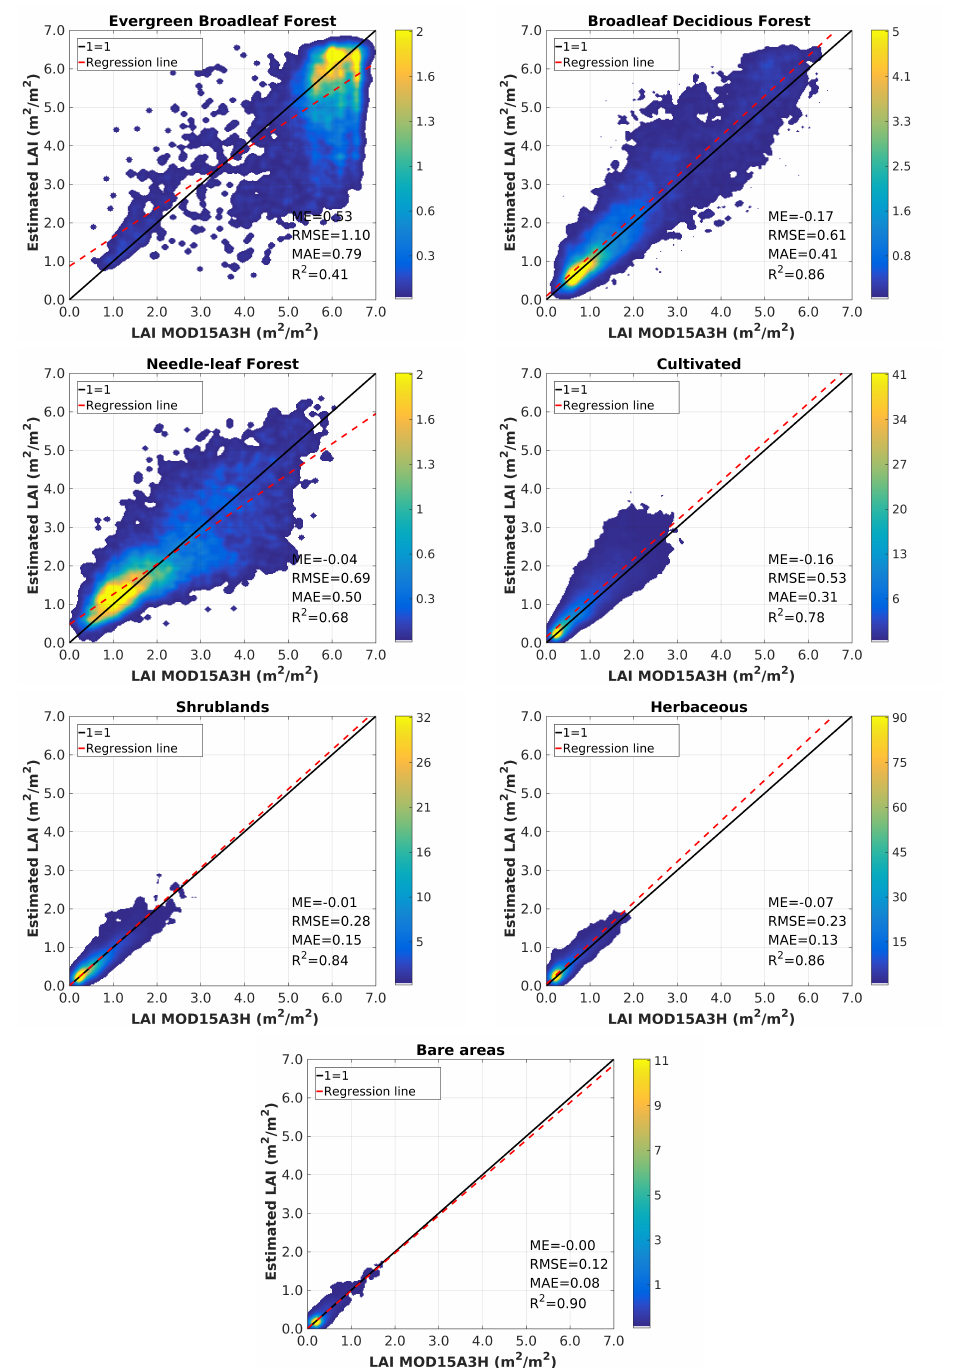
Figure 7. Biome-dependent scatter plots of the retrieved LAI over BELMANIP2.1 sites for the period 2002–2017. The colorbar indicates density of points in the scatter